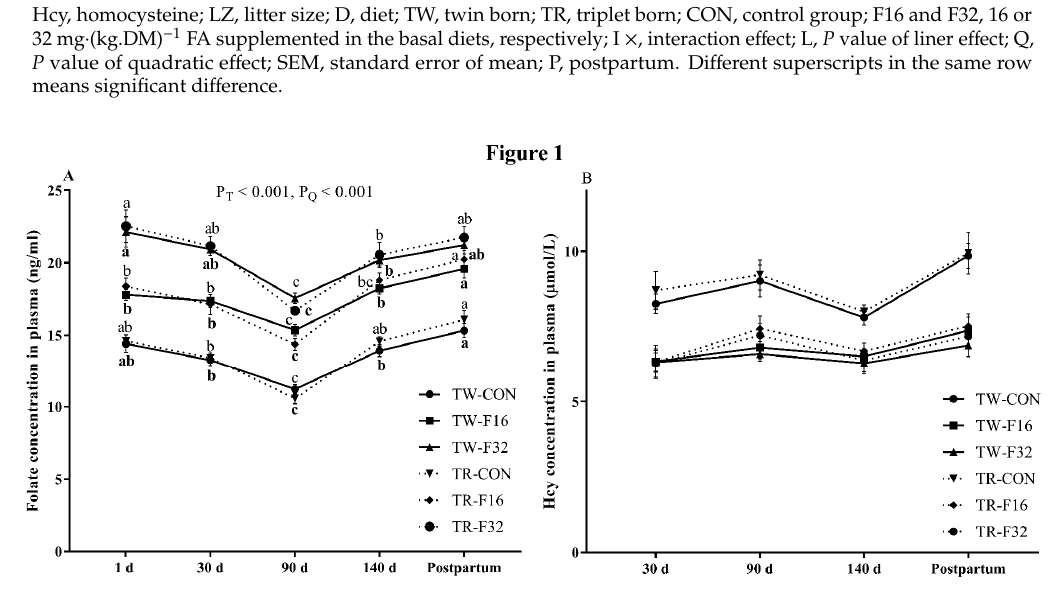
Figure 1. Folate ( A ) and Hcy ( B ) concentration in serum. Data are means ± SEM. Hcy, homocysteine; TW-CON, TW-F16 and TW-F32, twins born from ewes fed 0, 16, or 32 mg · (kg.DM) − 1 FA in the basal diet, respectively; TR-CON, TR-F16 and TR-F32, triplets born from ewes fed 0, 16, or 32 mg · (kg.DM) − 1 FA in the basal diet, respectively. P T , P value of time e ff ect; P Q , P value of quadratic e ff ect. Di ff erent lowercases indicated significance of corresponding TR groups (dotted line); di ff erent bold lowercases indicated significance of corresponding TW groups (full line). N = 5 for TR-CON, and n = 6 for other